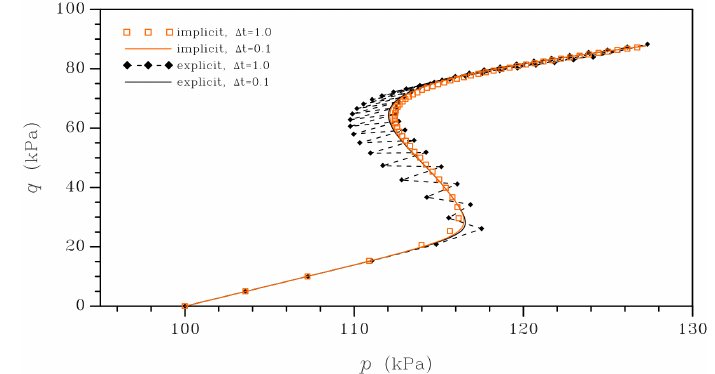
Figure 6. Test 2. Stress point evolution in the p − q